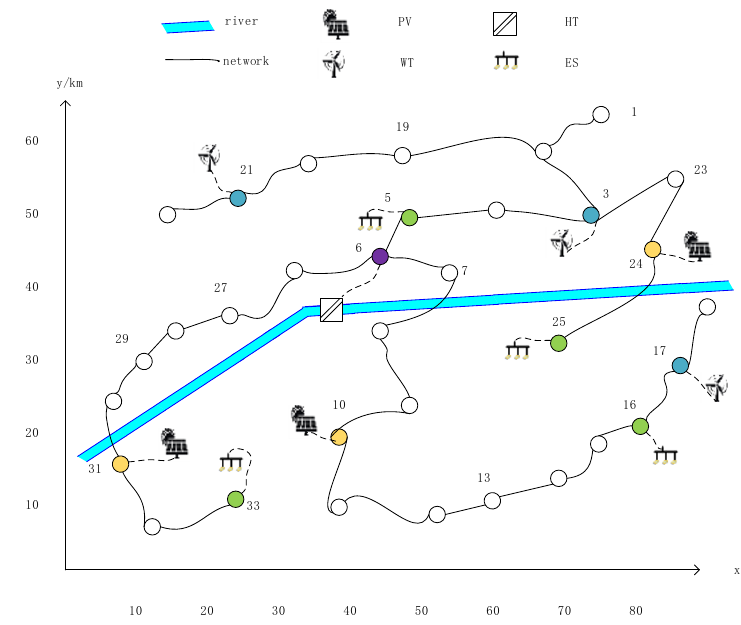
Figure 3. Candidate locations for WT, PV, HT, MT and ES stations.